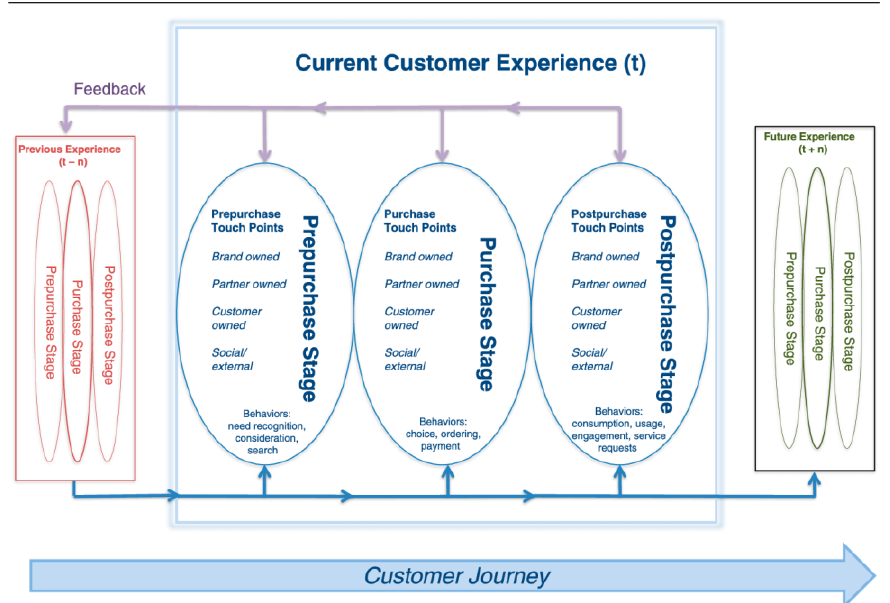
Figure 1. Customer journey maps (CJM) presenting the sequence of events [38].